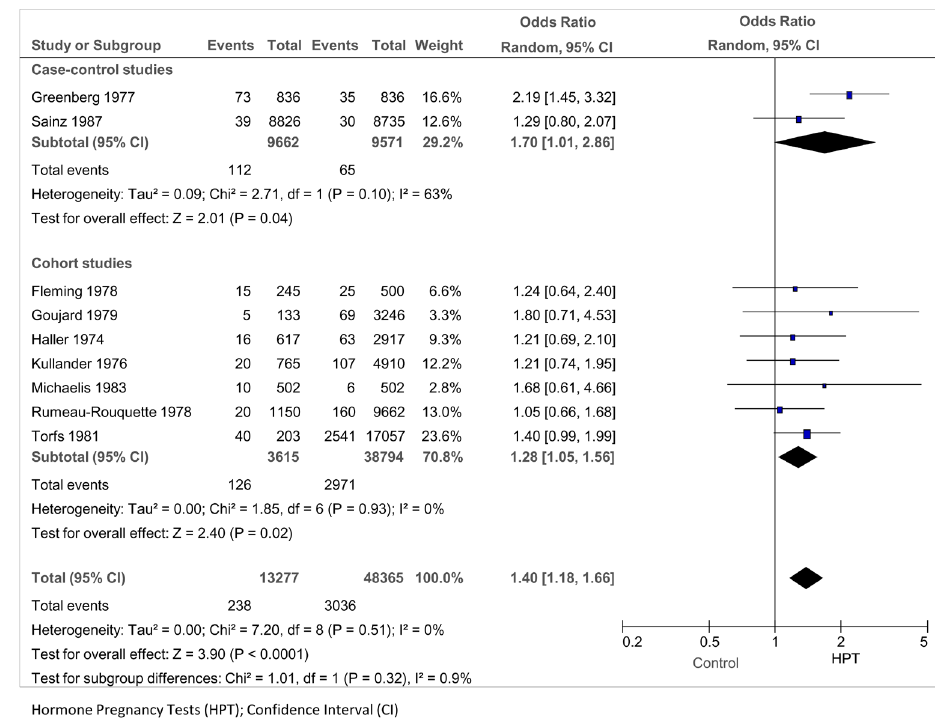
Figure 2. Association of exposure to oral HPTs in pregnancy with all malformations in the offspring.